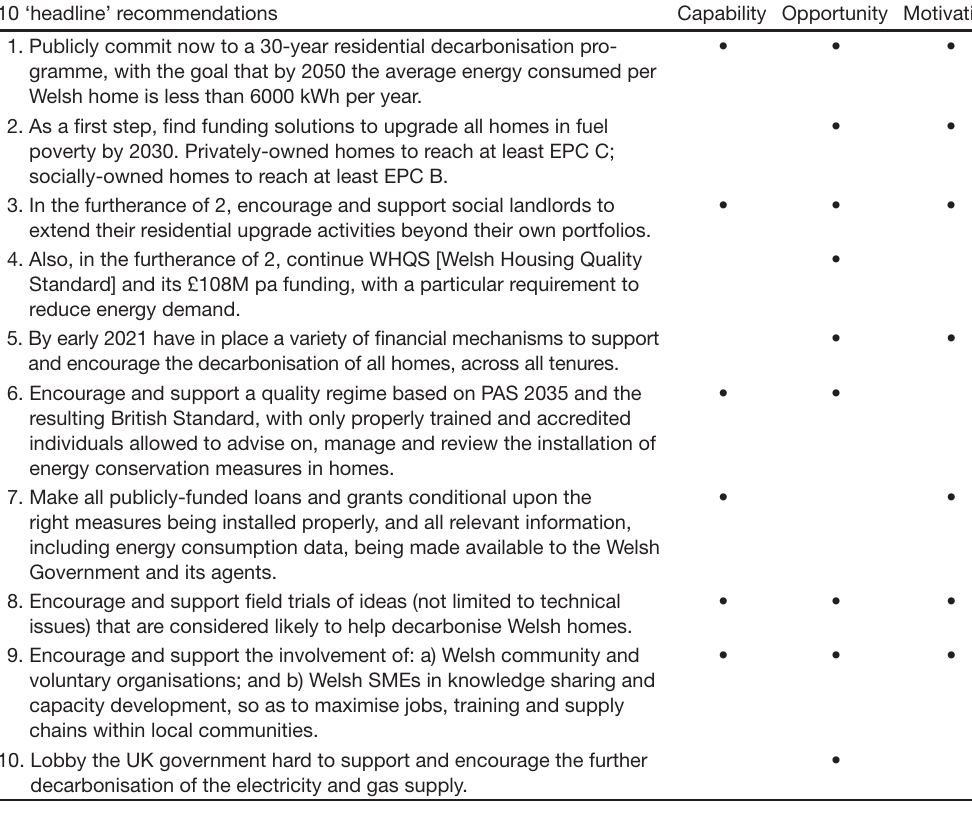
Table 3. 10 ‘headline’ policy recommendations mapped to the COM-B model 10 ‘headline’